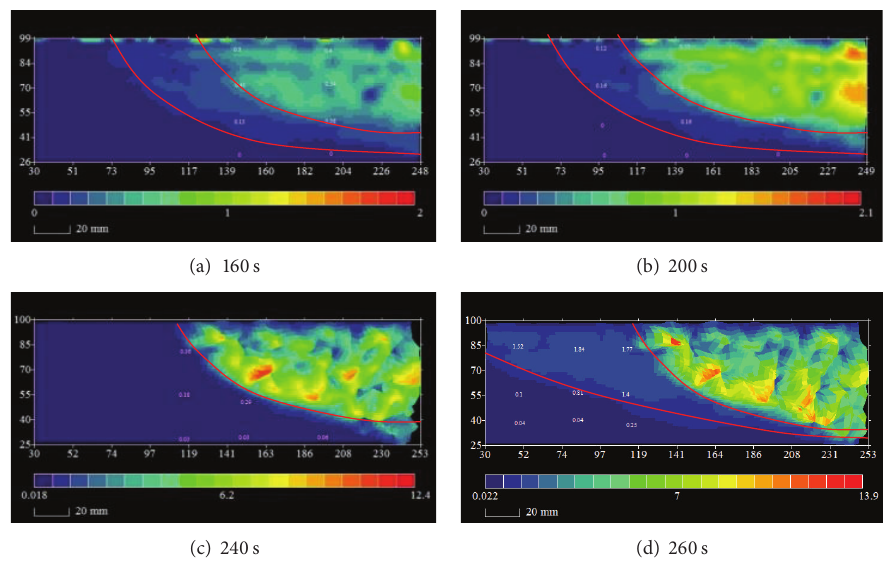
Figure 7: The deformation field of debris flow.